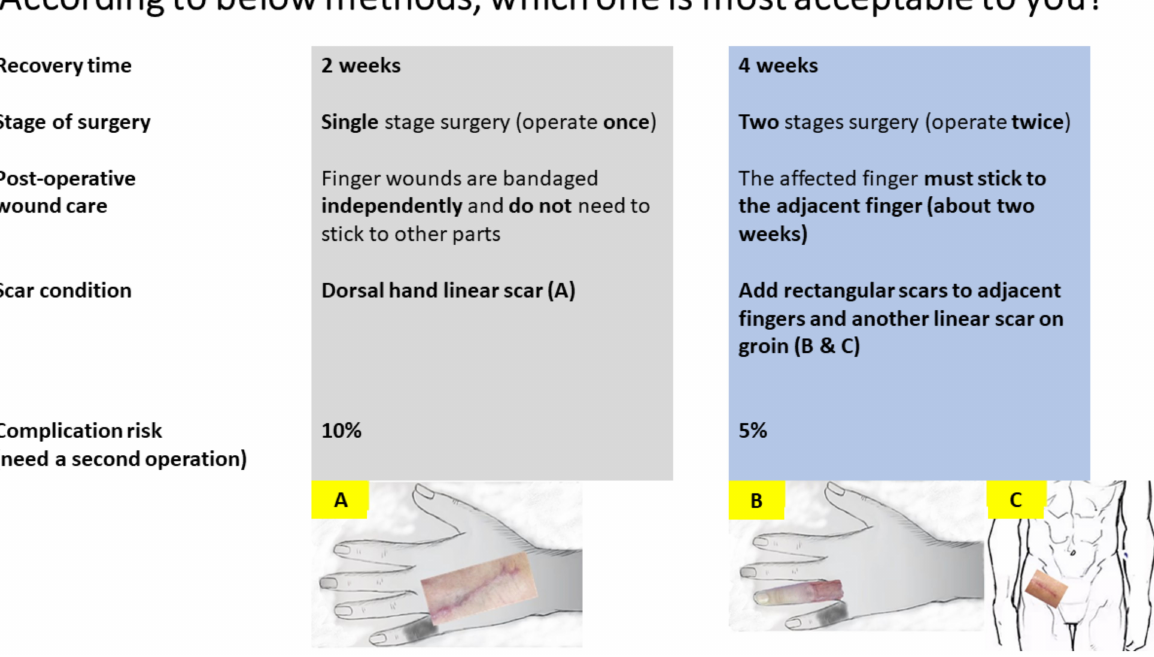
Figure 2. Representative example of 1 of 11 hypothetical choice experiments in the survey. The participants were asked to select one from the two treatment options. ( A ) Dorsal hand scar; ( B ) Finger scar; ( C ) Groin